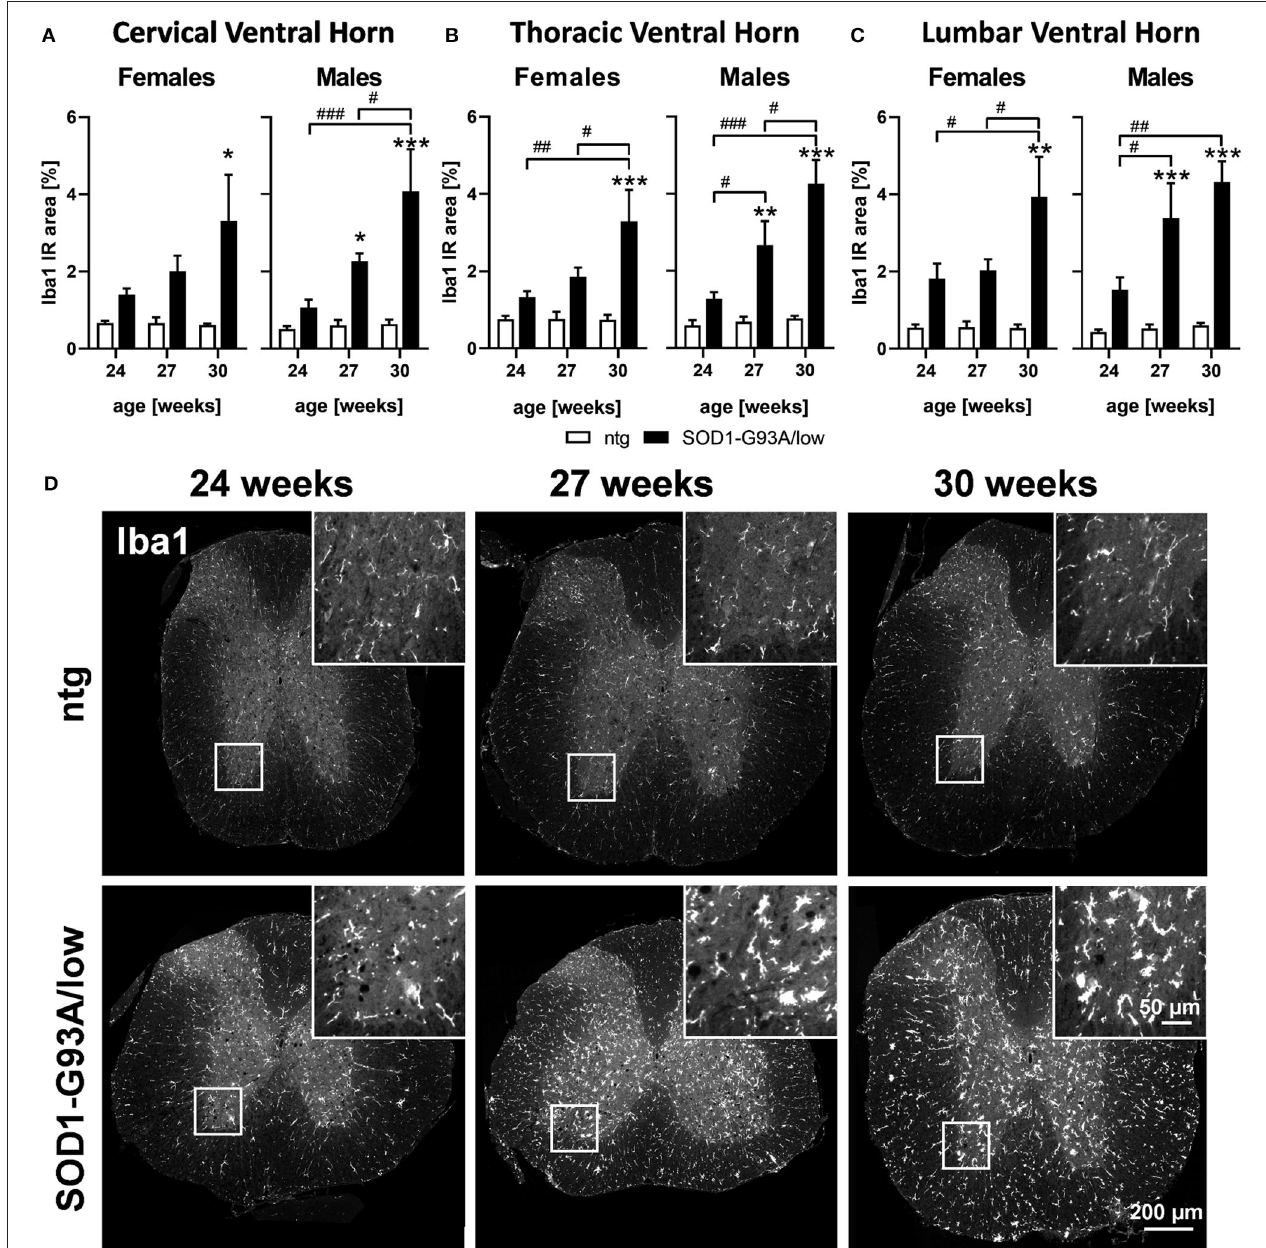
FIGURE 3 | Microgliosis in the spinal cord of 24–30 weeks old SOD1-G93A/low mice. Female and male 24, 27, and 30 weeks old SOD1-G93A/low mice were evaluated for ionized calcium-binding adaptor molecule 1 (Iba1) expression (A–C) in the cervical (A) , thoracic (B) , and lumbar (C) ventral horn compared to ntg littermates. Two-way ANOVA with Tukey’s and Sidak’s multiple comparison post hoc test; n = 4 per group. Mean + SEM. * / # p < 0.05, ** / ## p < 0.01, *** / ### p < 0.001. *Differences between genotypes; # differences between age groups. (D) Representative images of Iba1 labeling in the thoracic spinal cord of 24, 27, and 30 weeks old male SOD1-G93A/low mice compared to ntg littermates.